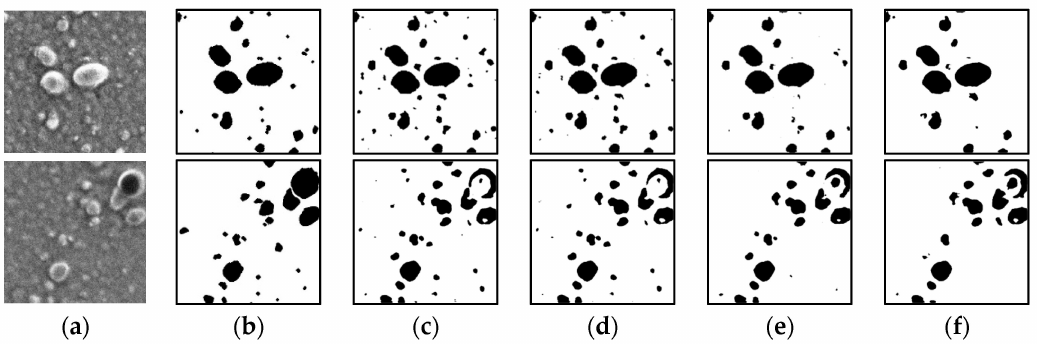
Figure 11. Results of image processing after segmentation (small number of particles). ( a ) Input data; ( b ) Output data (ground truth). Results obtained using ( c ) original ground truth data; and labeling data in which particles smaller than ( d ) 200 px; ( e ) 400 px; and ( f ) 600 px are removed.